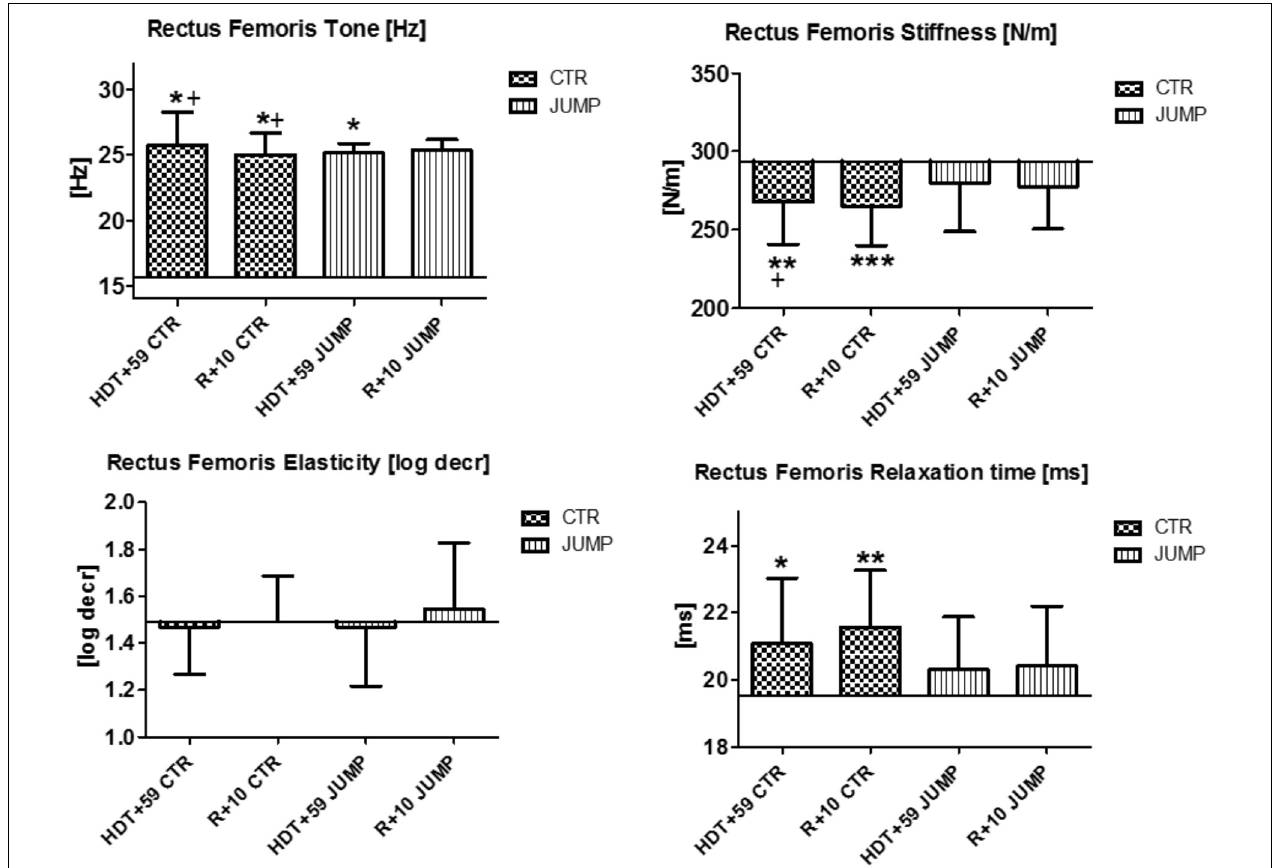
FIGURE 3 | Rectus femoris (MP5/6). Oscillation signal patterns in RSL bed rest study. ABL = Average Baseline (Tone HDT+1 = 15.64; Stiffness HDT+1 = 293.71; Elasticity HDT+1 = 1.49; Relaxation HDT+1 = 19.51). ∗ p < 0.05, ∗∗ p < 0.01, ∗∗∗ p < 0.001 ± SD, +Spearman ρ .